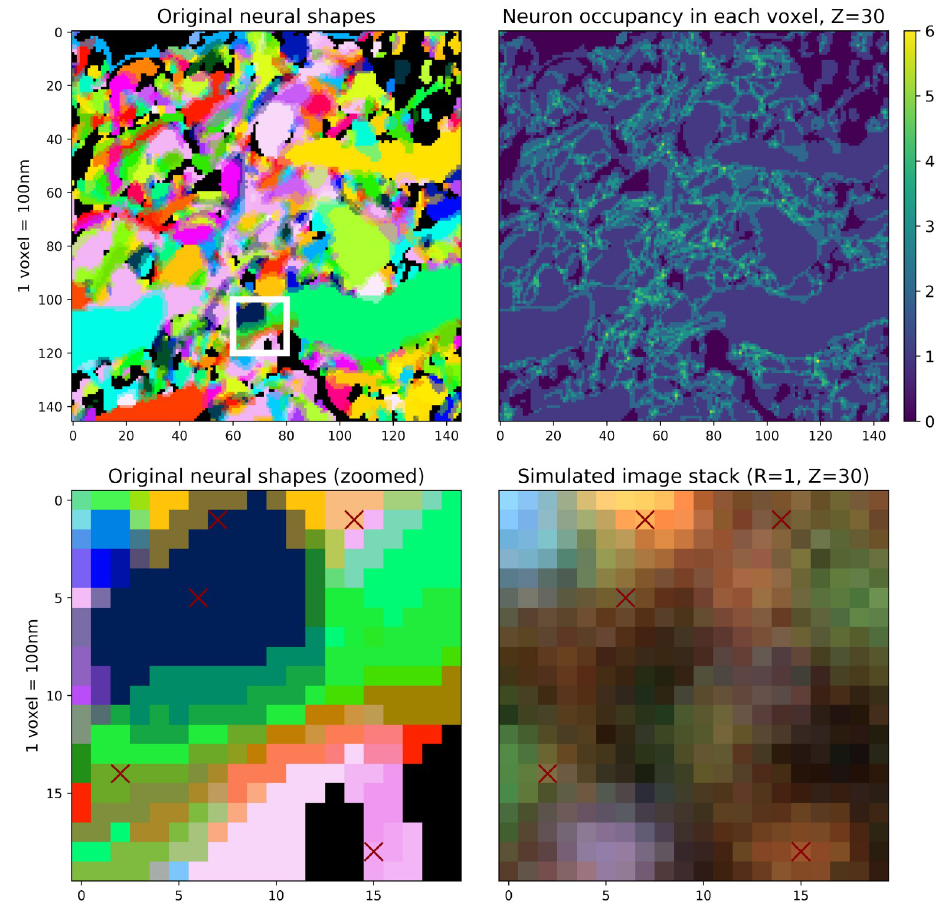
Fig 4. Limited optical resolution leads to signal mixing between neighboring neurons even in the high-resolution setting. Top left : Neuronal shapes in high-resolution, dense-expression data, as seen in Fig 3. Top right : The number of distinct neurons that contribute signal to each voxel. In some densely-packed regions, each voxel might mix signal from as many as six cells, due to optical blur and the voxelization process. Bottom left : Zoomed-in 20 × 20 region of the original neuronal shapes (the white rectangular region from the top left panel). Bottom right : Simulated imagestack in the same region, illustrating the challenge of uniquely assigning amplicons to neurons ( λ = 10 amplicons/ μ m 3 here). Simulated amplicon locations within this z-plane are shown with red crosses; other amplicons centered outside of this z-plane contribute additional signal.